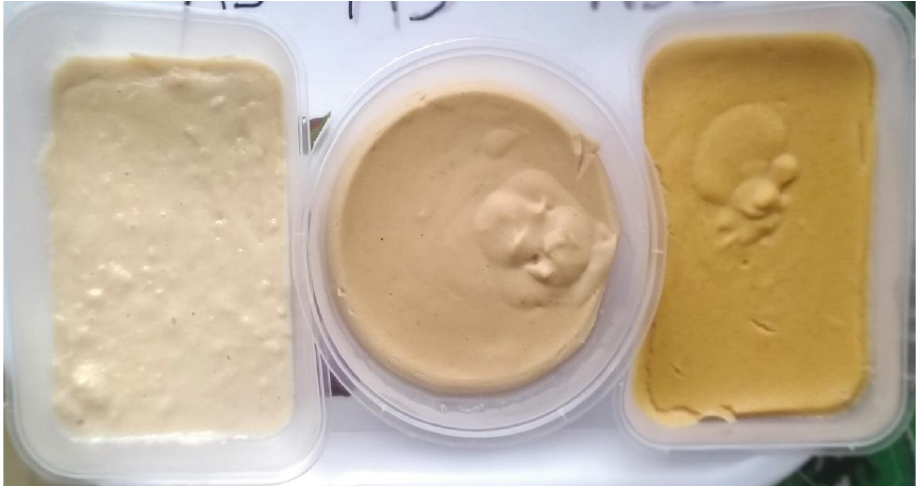
Figure 7. Different blends of the cooked formulated complementary food. They are arranged from left to right (CTRL, AS and ASO). Table 7. Sensory scores of complementary food produced from blends of fonio, soyabean and orange-fleshed sweet potatoes with a commercial control (wet basis).